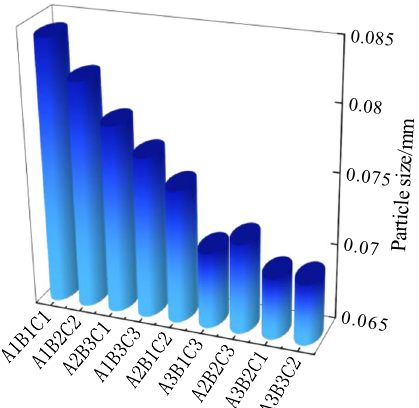
Figure 15. Graph of particle size versus fractality.